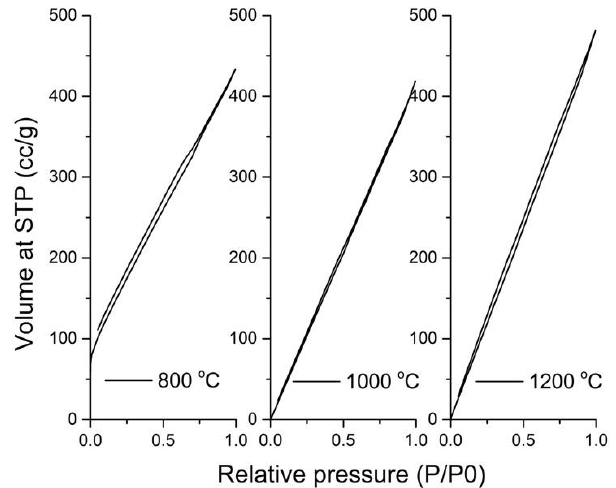
Figure 6. Nitrogen adsorption-desorption isotherm of carbonized Kevlar fabrics.